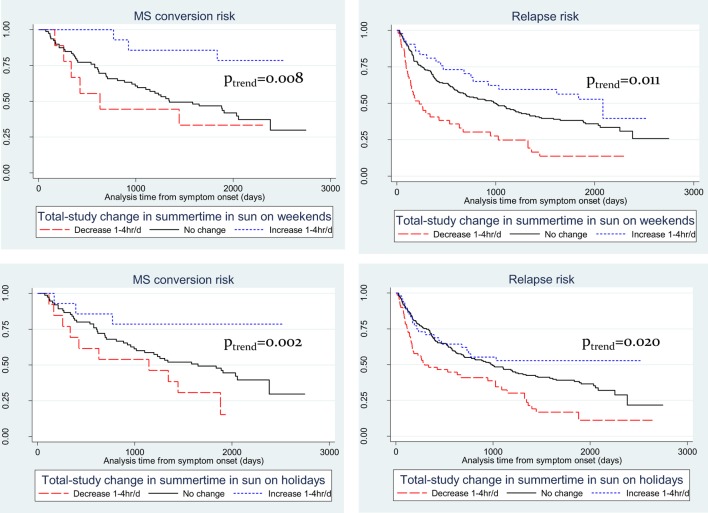
Kaplan–Meier plots of recreational summer sun exposure durations and risk of conversion to multiple sclerosis (MS) and of relapse. (A) summer weekend and MS; (B) summer weekend and relapse; (C) summer holidays and MS; and (D) summer holidays and relapse.